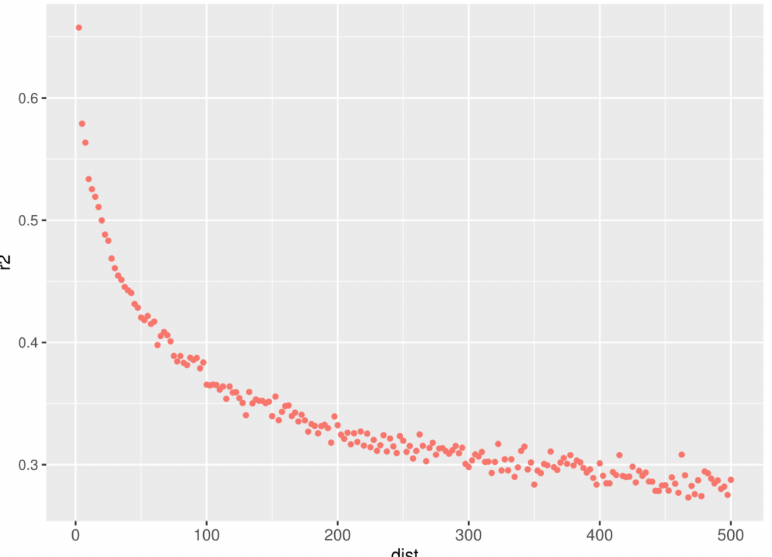
Figure 3. Linkage disequilibrium (LD) decay in different distances of the genome and up to 500 Kb on DBSC